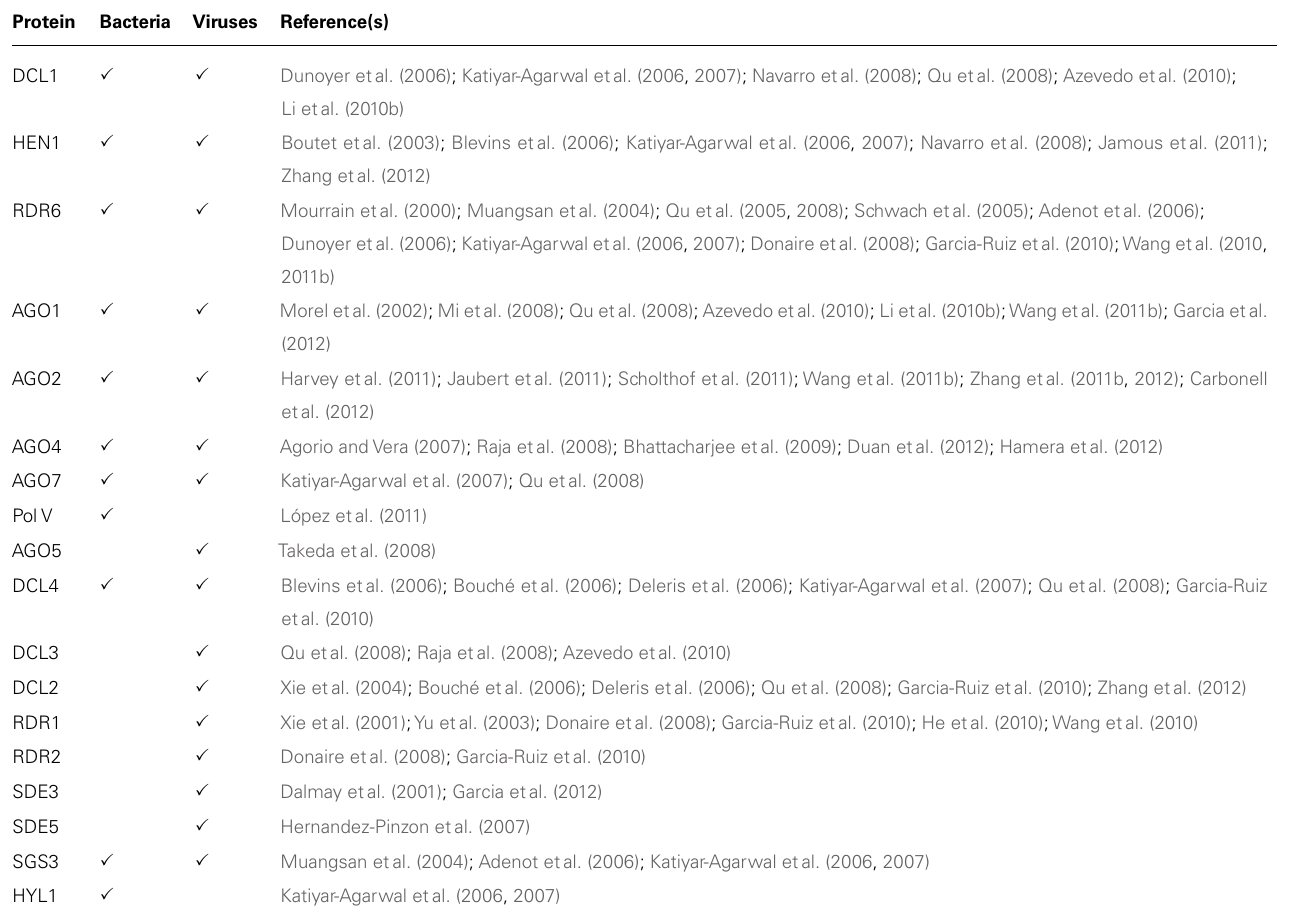
Table 2 | Small RNA biogenesis factors involved in plant defense. Protein Bacteria Viruses